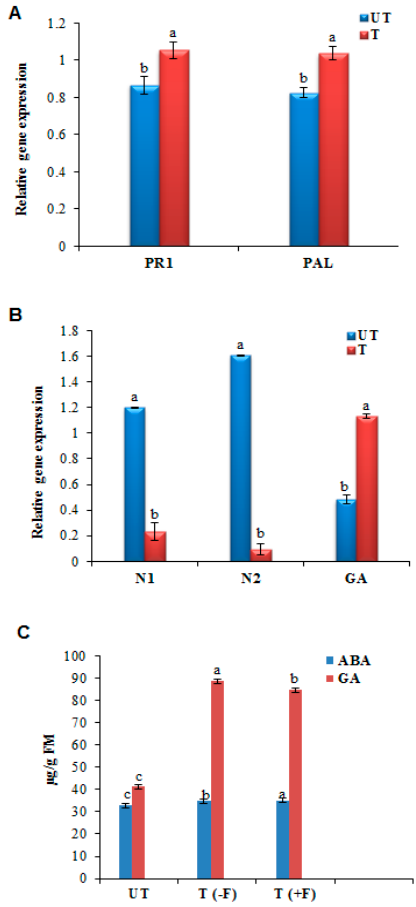
Figure 3. Quantitative Real-Time gene expression analysis of ( A ) Pathogenesis related ( PR ) genes, PR-1 and PAL (phenylalanine ammonia-lyase), ( B ) Abscisic acid (ABA) biosynthesis pathway genes, N1 (9-cis-epoxycarotenoid dioxygenase 1), N2 (9-cis-epoxycarotenoid dioxygenase 2), and GA biosynthesis pathway gene (Gibberellic acid 20 oxidase), and ( C ) Estimation of phytohormones such as ABA and GA hormone in the in control (UT) and GalUR transgenic (T) transgenic potato. T (-F) denotes the transgenic plant without P. infestans , and T (+F) denotes the plant infected with the fungal strain. Data are presented as means ± SD of three replicates. Different letters indicate a significant difference at p ≤ 0.05.